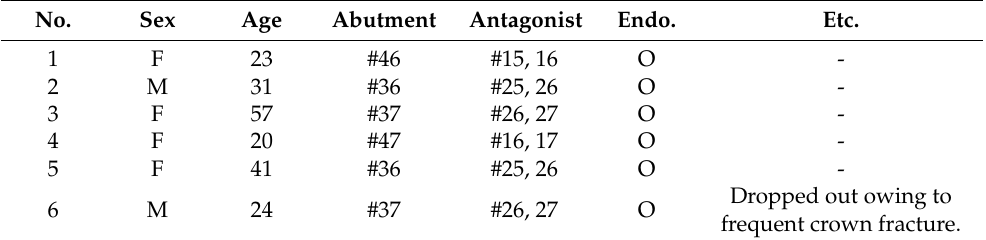
Table 1. The profiles of the